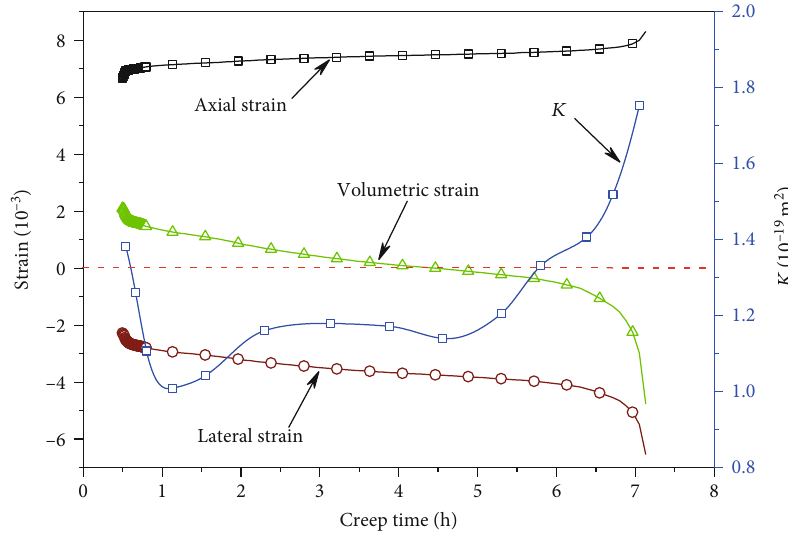
Figure 10: Creep-seepage test result at the fi nal deviatoric stress